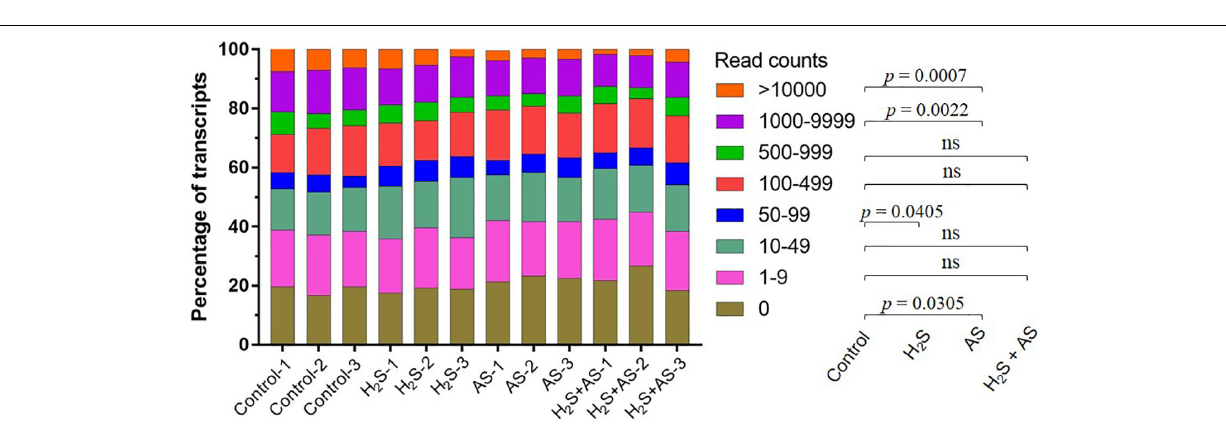
FIGURE 2 | The read content frequencies of miRNAs in different libraries. Three biological repetitions were performed for each treatment. The significant differences ( P < 0.05) between different treatment are shown on the right. AS, alkaline salt. ns, not